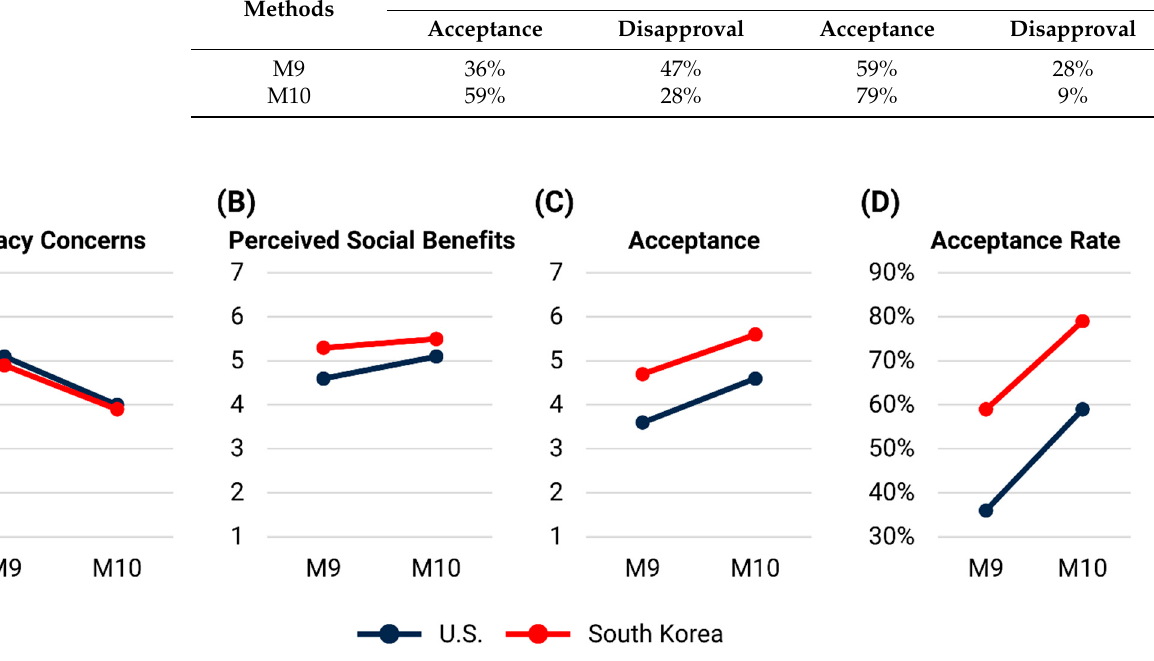
Table 11. Acceptance and disapproval rates of the two location disclosure methods.